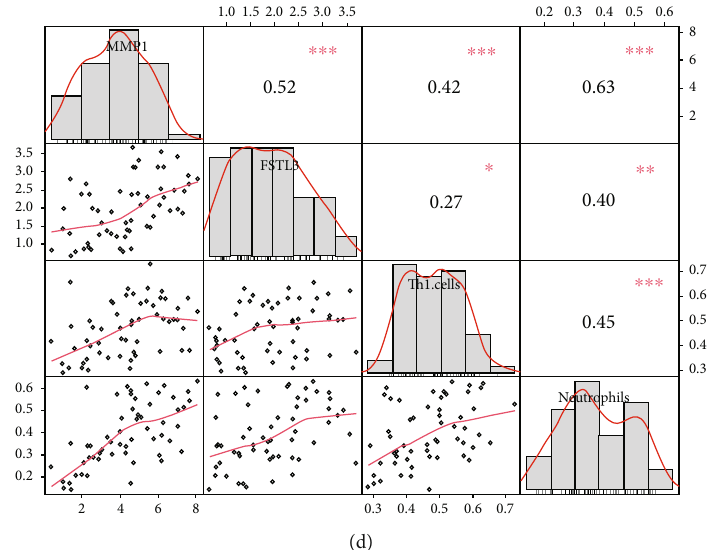
Figure 6: Correlations between di ff erentially expressed, worse-survival-related SMPs, and the in fi ltrations of immune cells: (a) correlations in the TCGA dataset; (b) correlations in GSE127165; (c) correlations among MMP1, FSTL3, Th1 cells, and neutrophils in the TCGA dataset; (d) correlations among MMP1, FSTL3, Th1 cells, and neutrophils in